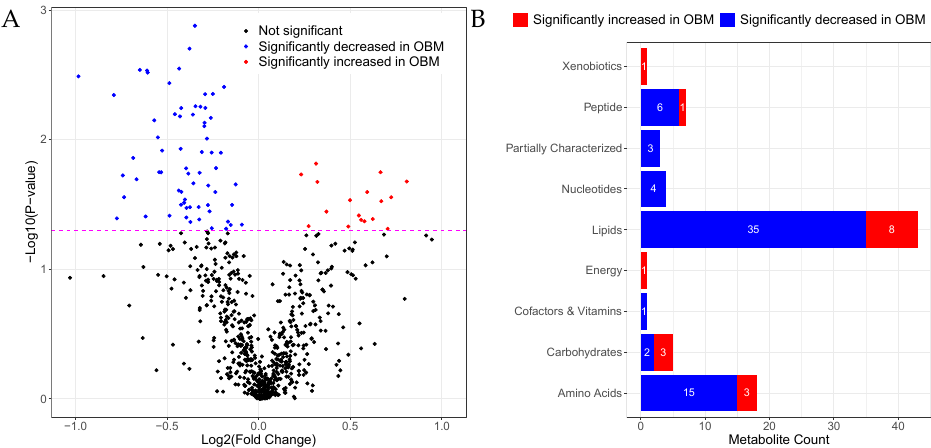
Figure 1. Changes in metabolite concentrations in OBM vs. OBO. ( A ) Volcano plot of log2(fold- change) versus –log10( p -value) of metabolites. Metabolites above the dashed line have p < 0.05. ( B ) Bar plot showing the number of metabolites significantly increased or decreased in a super pathway.